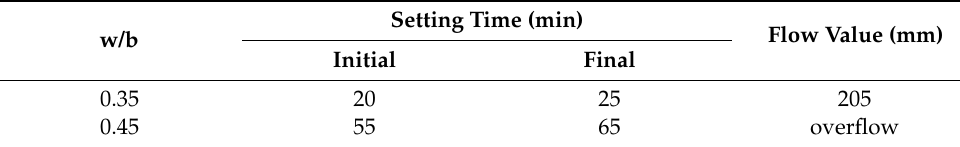
Table 3. Setting time and flow value of the mixture without ZP (23 ± 2 ◦ C). Setting Time w/b